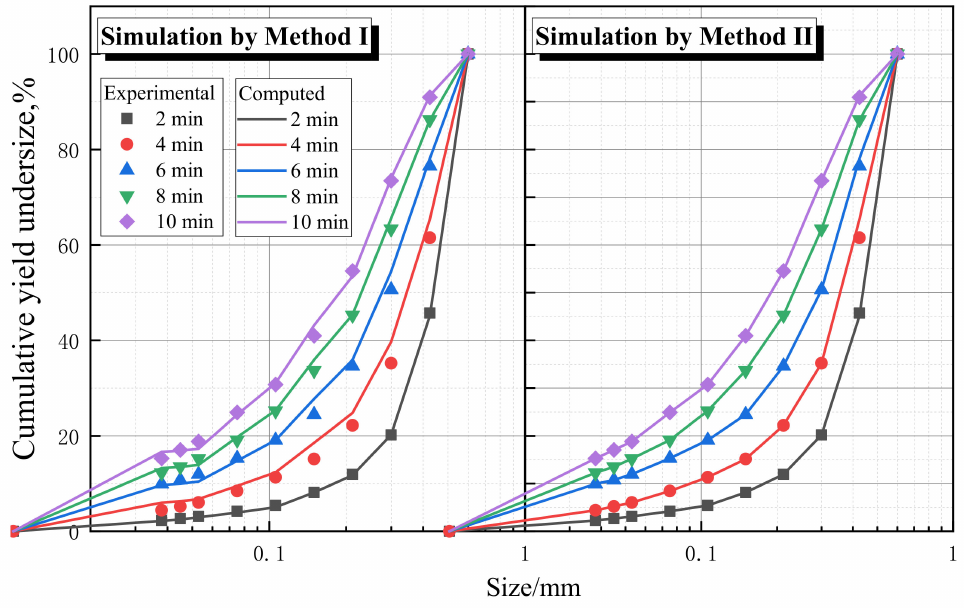
Figure 8. Simulations using the two methods in the grinding of − 0.600 + 0.425 mm